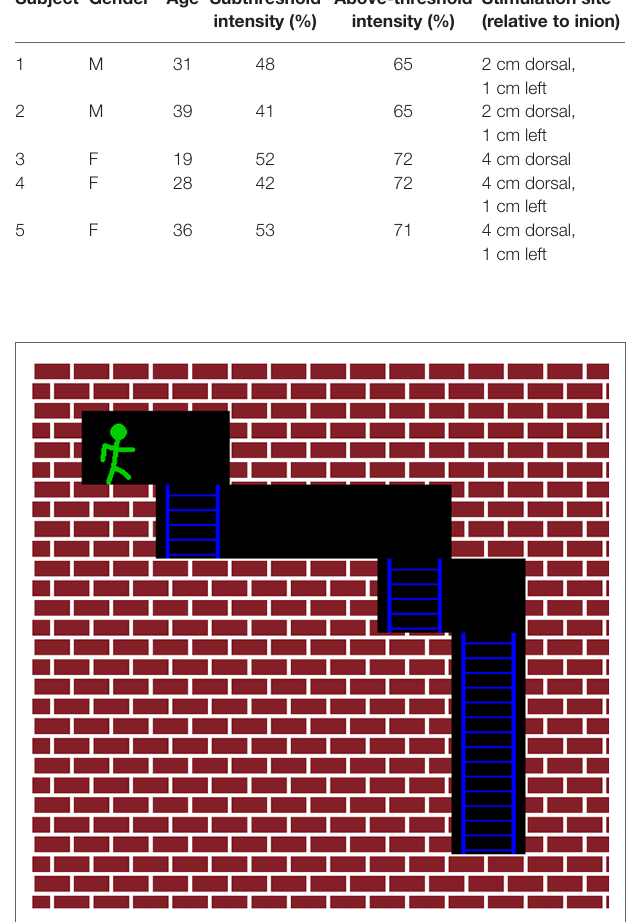
FigUre 1 | This figure illustrates the starting position of the second maze (see Figure 2) . The subject’s avatar starts in the upper-left corner of the maze. The goal is to move the avatar toward the bottom-rightmost position. The intensity of the TMS pulse is determined by the position of the closest wall in front of the avatar. If a wall is directly in front of the avatar, the subject receives an above-threshold pulse. A subthreshold pulse is fired if there is no wall directly in front of the avatar, as in this figure.